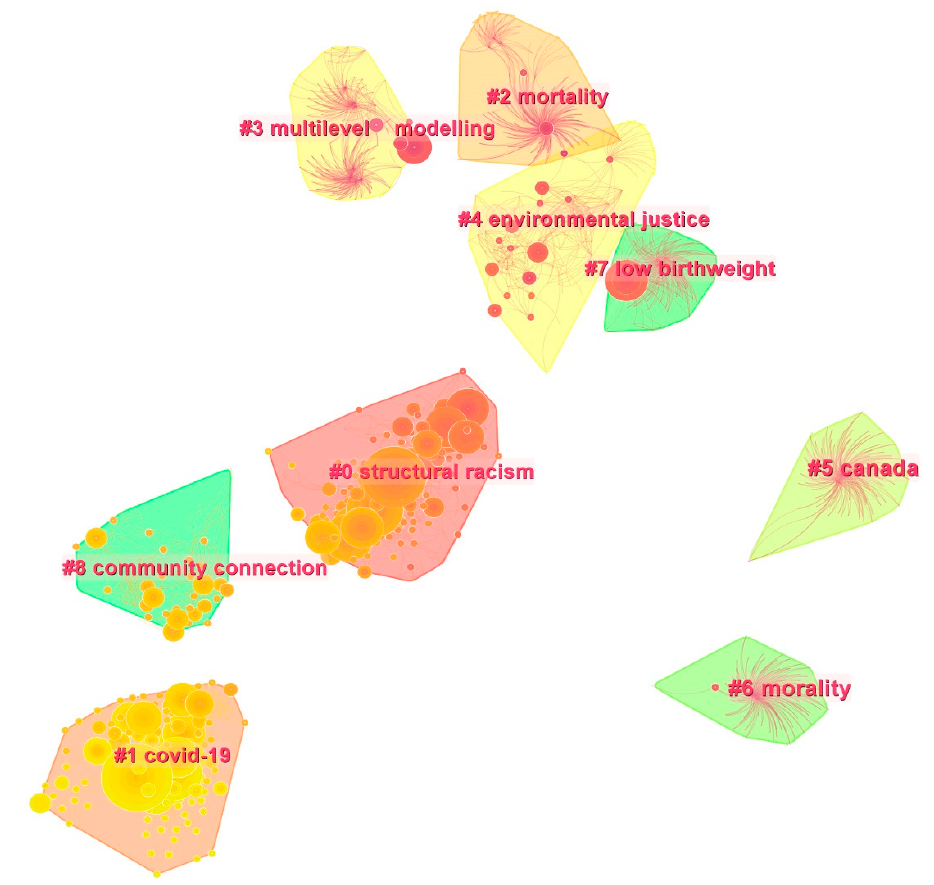
Figure 5. Clustering map of reference co-citations in RSH research.